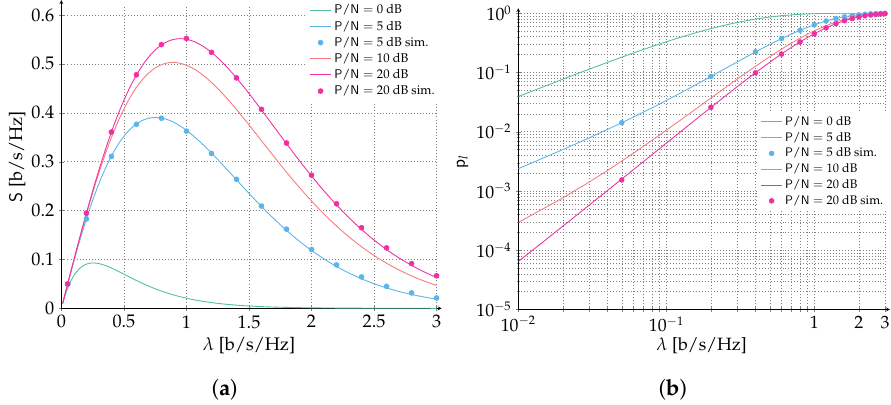
Figure 4. Performance of time and frequency ALOHA with forward error correction. The channel bandwidth to transmission bandwidth ratio is B / W = 500. Data units are protected with a Gaussian codebook of rate R = 1 bits per symbol. We select the SNR in the range P / N Analytical results (continuous lines) are compared with Monte Carlo simulations (dots). ( a ) Spectral efficiency; ( b ) Packet loss